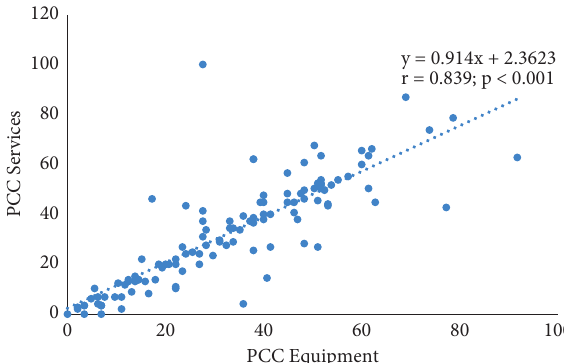
Figure 2: Relationship between perceived adequacy of PCC equipment and PCC